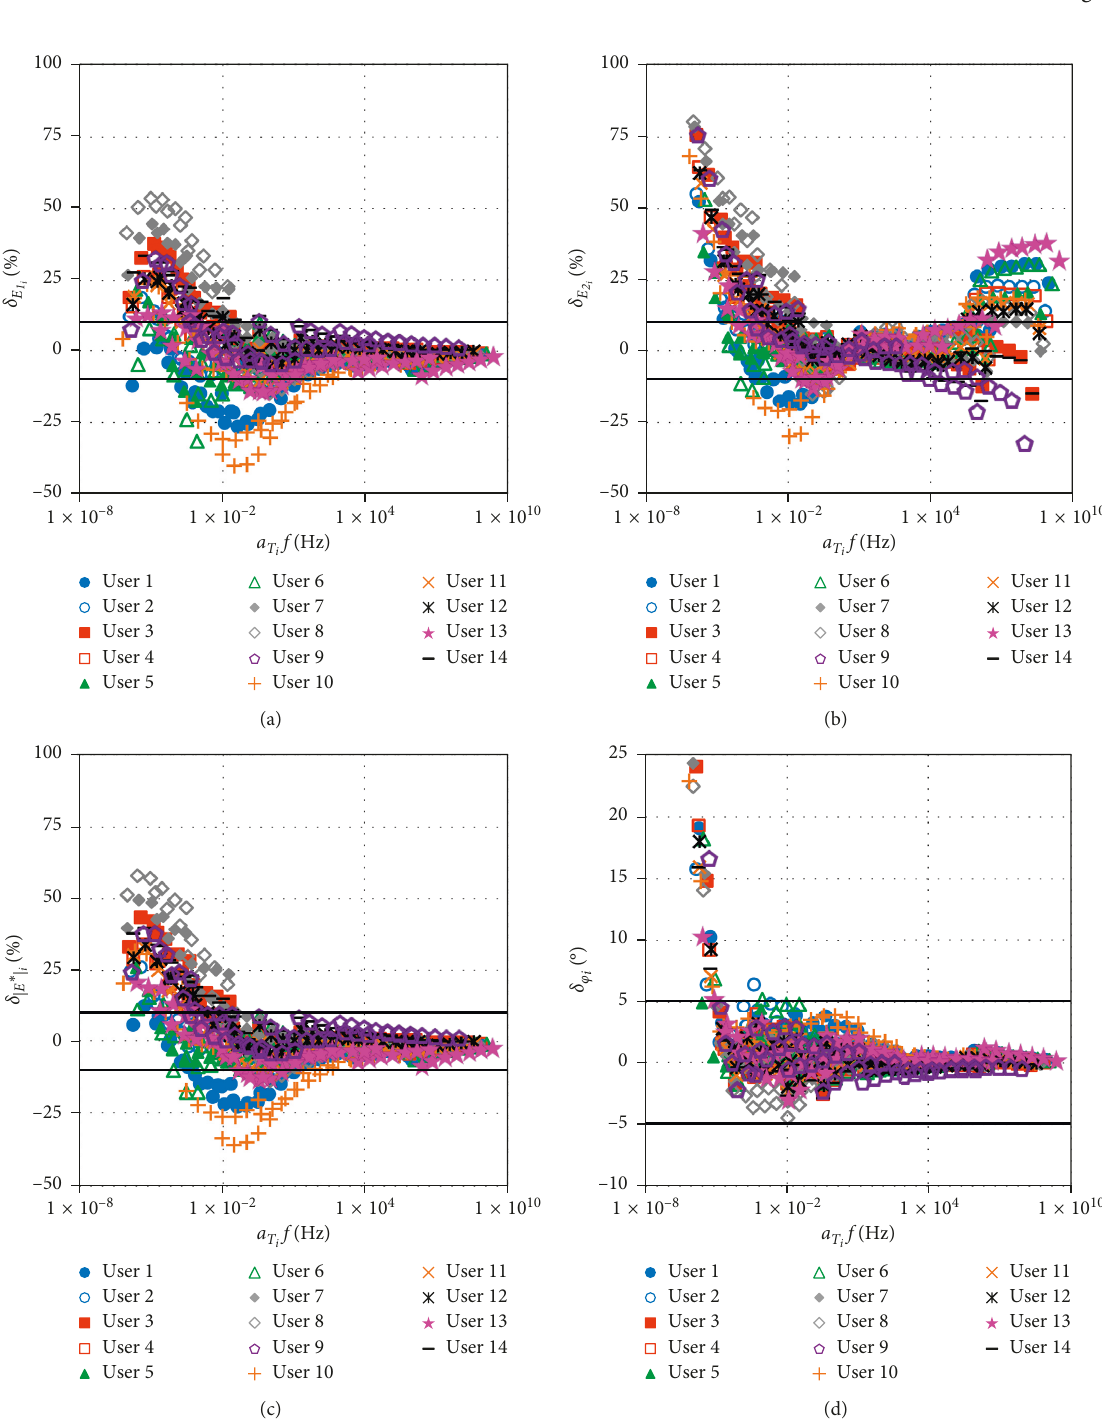
° C): relative errors for ref (cid:31) 9.53